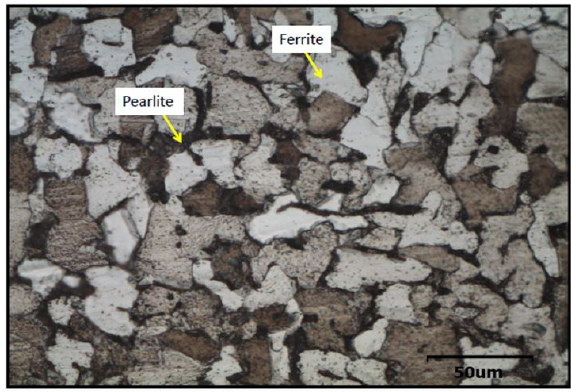
Figure 2: Optical microstructure of base metal.